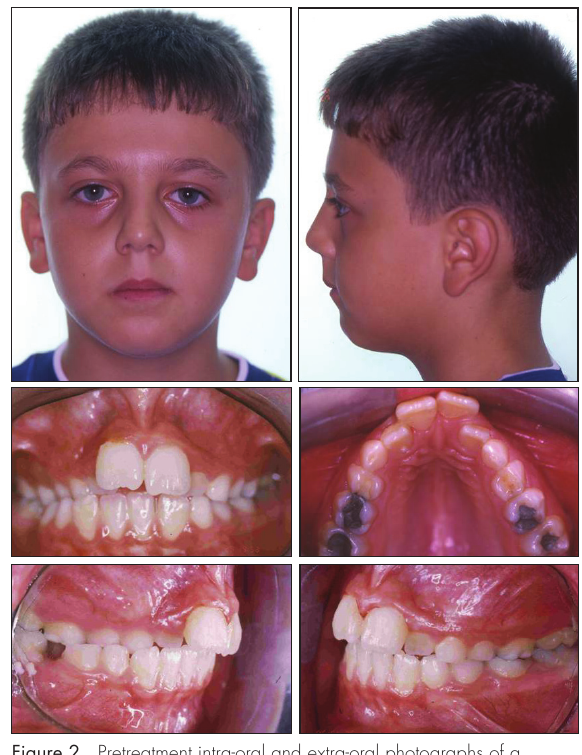
Figure 4. Intra-oral and extra-oral photographs of a patient after retention